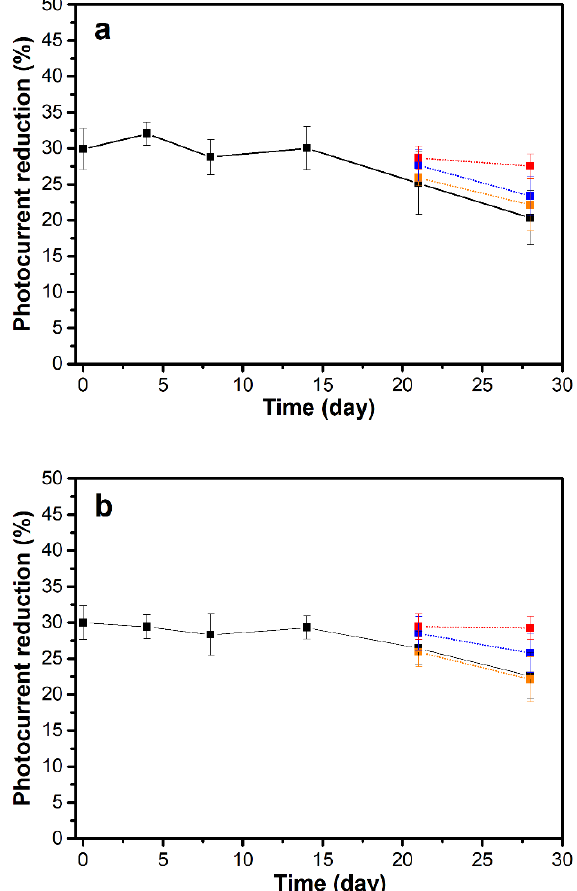
Figure 6. The e ff ect of storage on the decrease in the photocurrent in ( a ) HbA0 and ( b ) HbA1c aptasensors for the detection of 1 µ g / mL pure HbA0 and HbA1c, respectively. The aptasensors were stored in 10 mM PB containing 100 mM NaCl at pH 8.0 and 4 ◦ C for 0–28 days. After storage, the aptasensors were either (black) directly used to detect their respective targets or (orange, blue, red) refolded and then used for target detection. The refolding process involved thermal denaturation of the stored aptasensors at 45 ◦ C for (orange) 10 min, (blue) 20 min and (red) 30 min, followed by a 30-min cooling period. All the data is presented as the average value for three chips of a single type with one standard deviation (RSD < 5%).